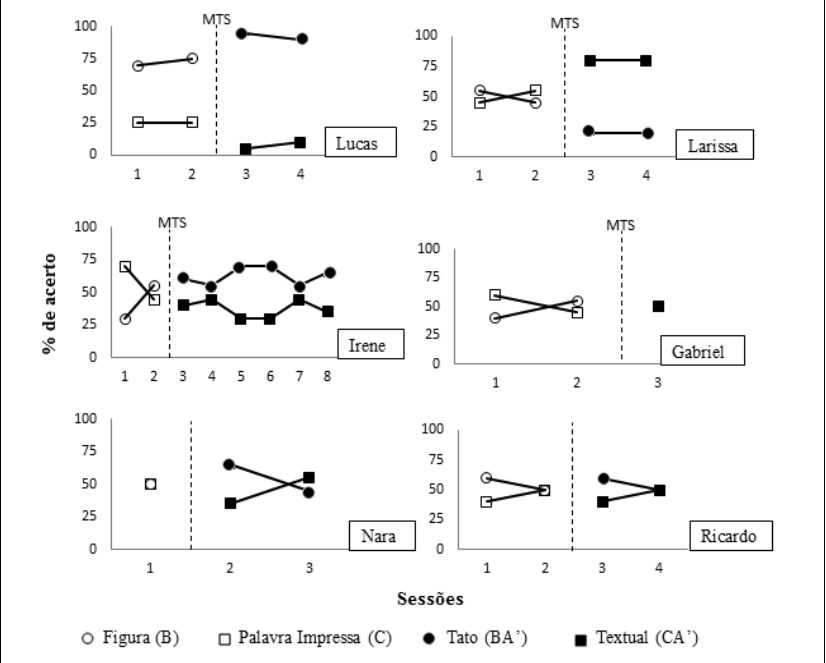
Figura 4 . Desempenho dos universitários na avaliação de preferência B vs. C e por tarefas BA’ vs.